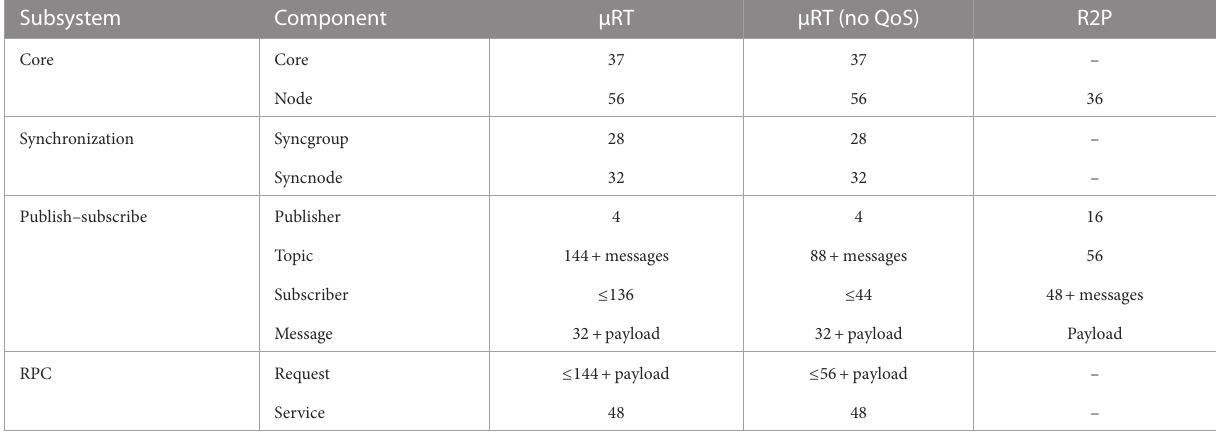
TABLE2 MemoryfootprintsofthemostimportantcomponentsofµRTandR2P(Migliavacca,2013).Forthesemeasurements,µRThasbeenconfiguredto reasonablesettings,e.g.,identifiersizesfor topics and services weresetto16bits.Allvaluesaregiveninbytes.